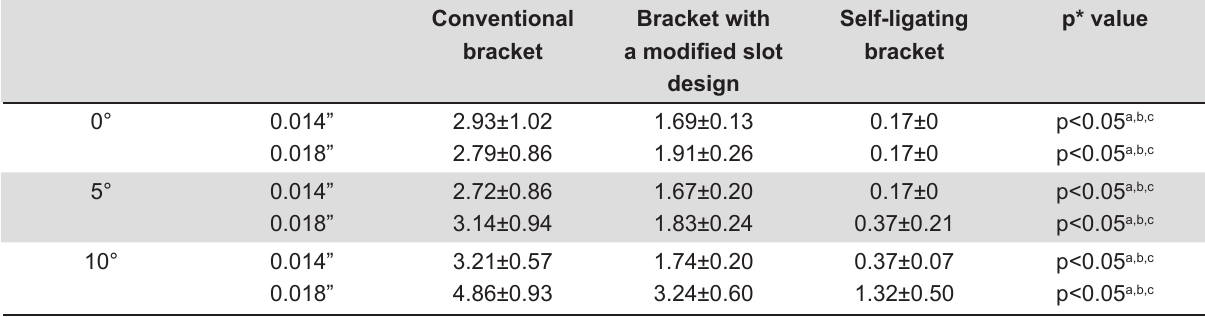
Table 2- Mean and standard deviation of frictional force (N) between different types of brackets, angulations and gauge: a comparison between different types of